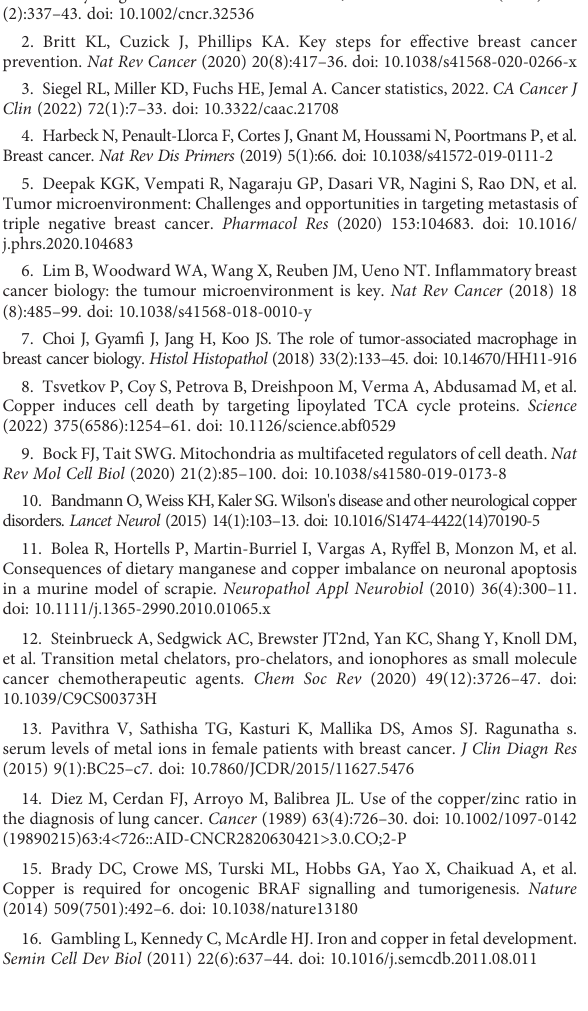
SUPPLEMENTARY FIGURE 1 PCA analysis for the construction of CuproptosisClusters. SUPPLEMENTARY FIGURE 2 PCA analysis for the construction of Gene Subtypes. SUPPLEMENTARY FIGURE 3 Validation of the cuproptosis-related gene signature in different BRCA subtypes of testing cohorts. SUPPLEMENTARY FIGURE 4 The survival analysis and expression of Cuproptosis-related gene signature in